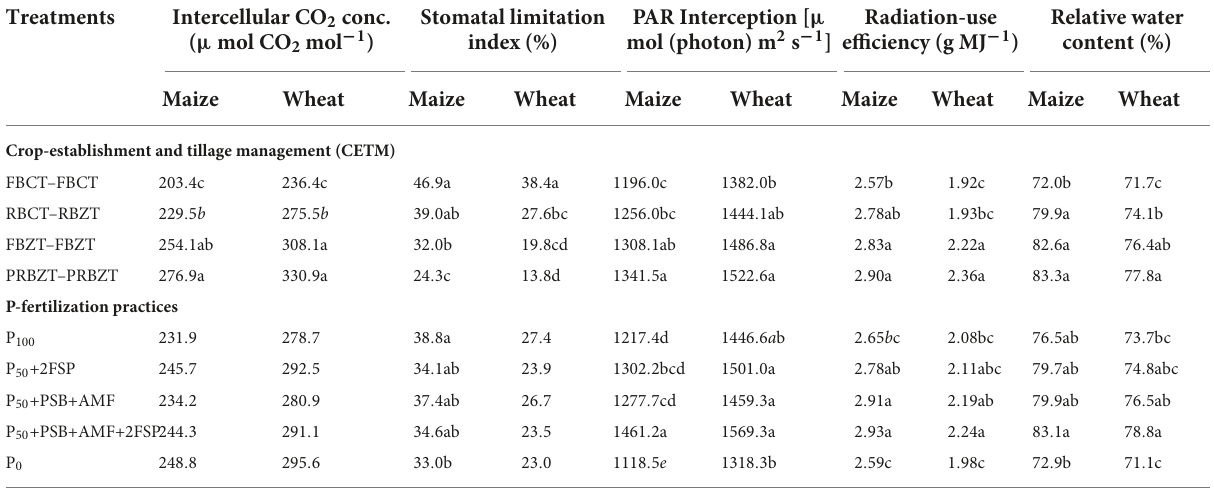
TABLE 3 Influence of crop-establishment and tillage management (CETM) and P-fertilization practices on internal CO 2 concentration, stomatal limitation index, PAR interception and relative water content at flowering stage as well as radiation-use efficiency of maize and wheat under MWCS. Treatments